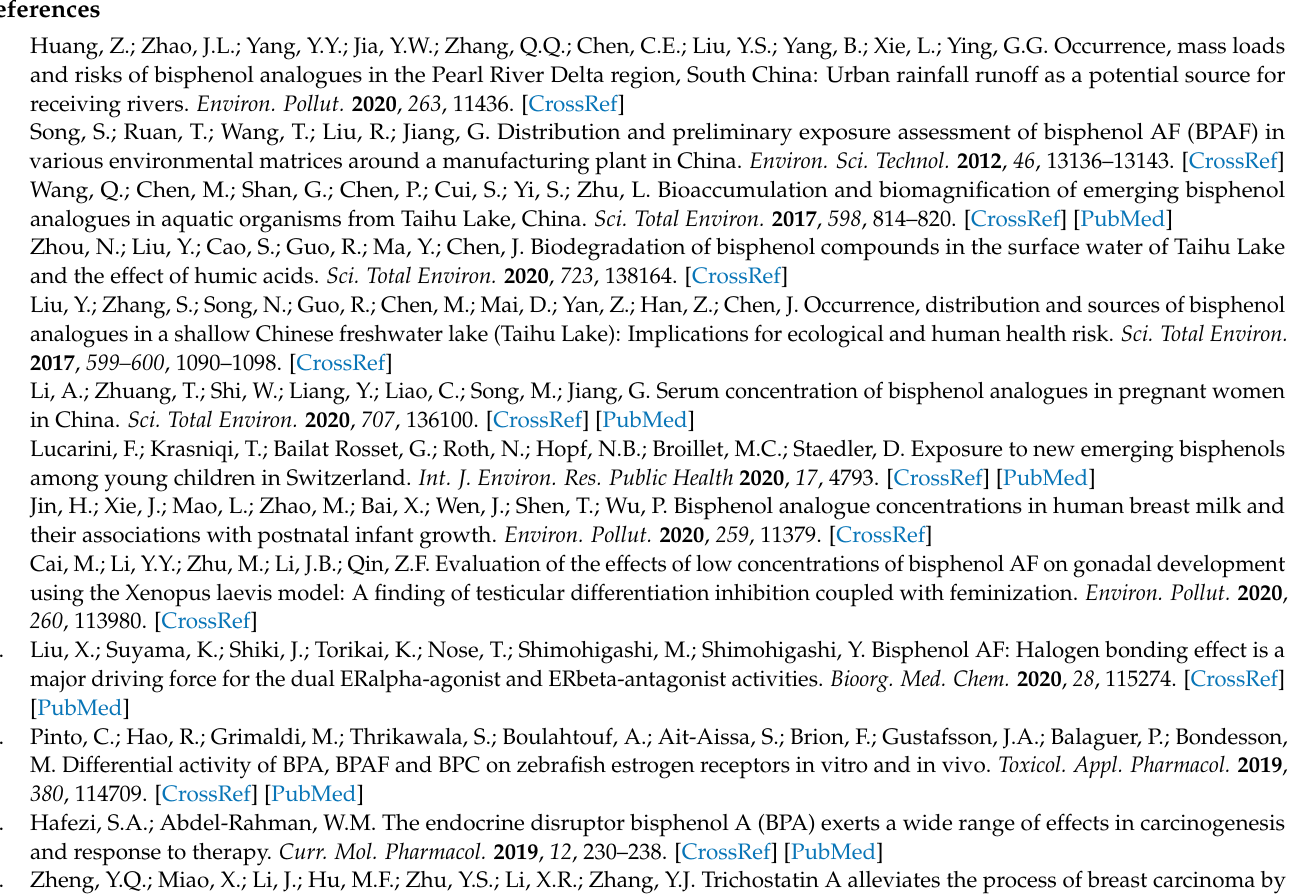
Table S2. Effect of BPAF on organ coefficients (%, mean ± SD) of liver, kidney and hypothslamus from Balb/cA nude mice with SK-BR-3 xenograft tumor. Figure S1. Effect of BPAF in different exposure days on body weight (g, mean ± SD) of Balb/cA nude mice with SK-BR-3 xenograft